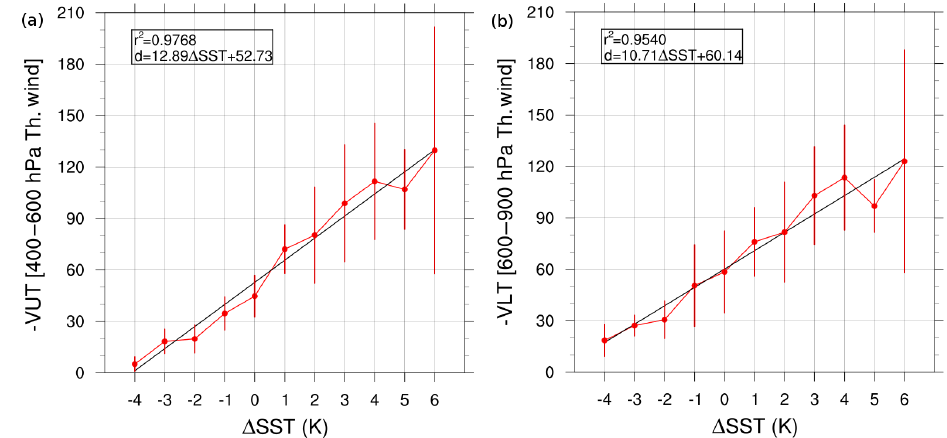
Figure 8. Dependence of composite of (a) − V U